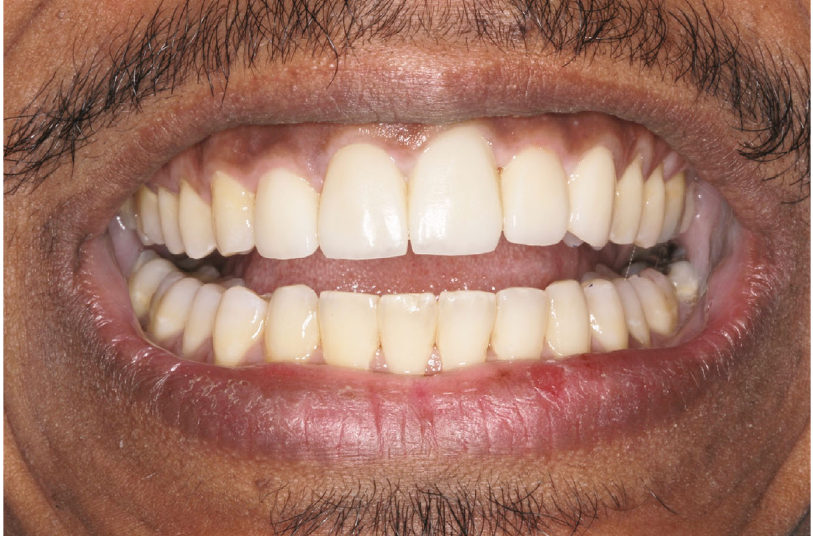
Figure 6: Postoperative clinical presentation of the de fi nitive implant-supported crown of tooth